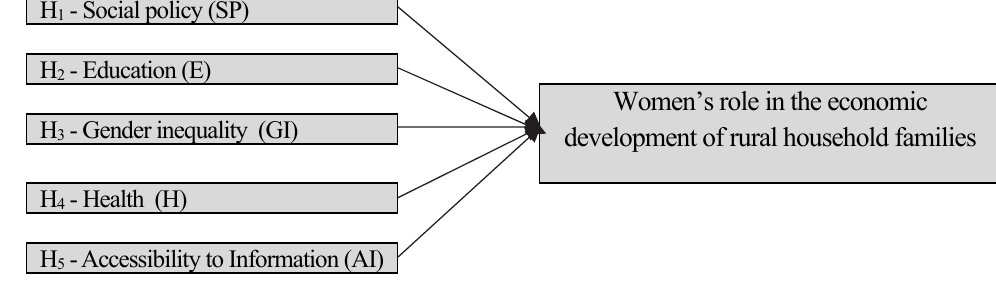
Fig.1. Research model (Source: Synthesis of